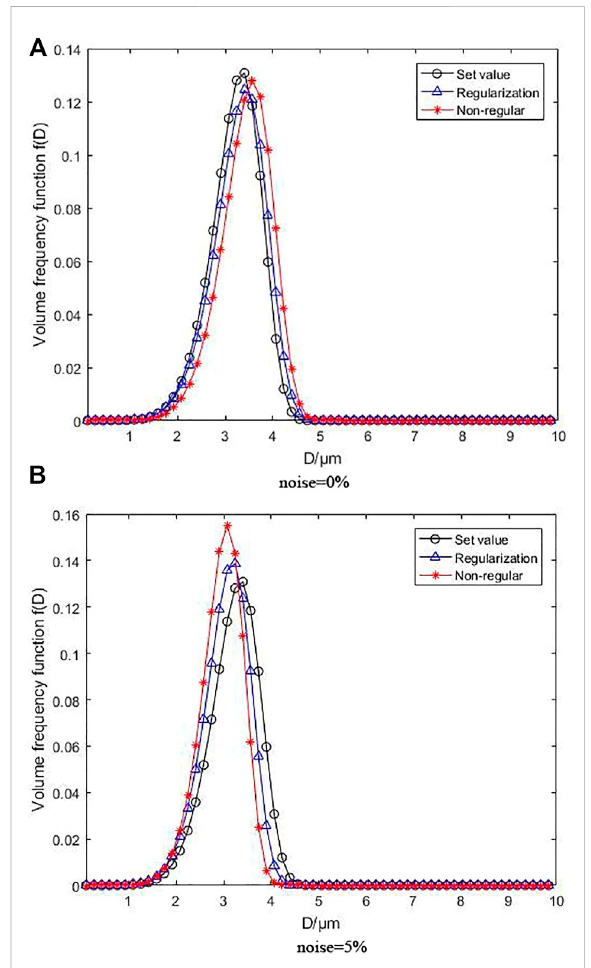
FIGURE 3 Inversion results following unimodal R-R distribution without noise and with 5% noise.